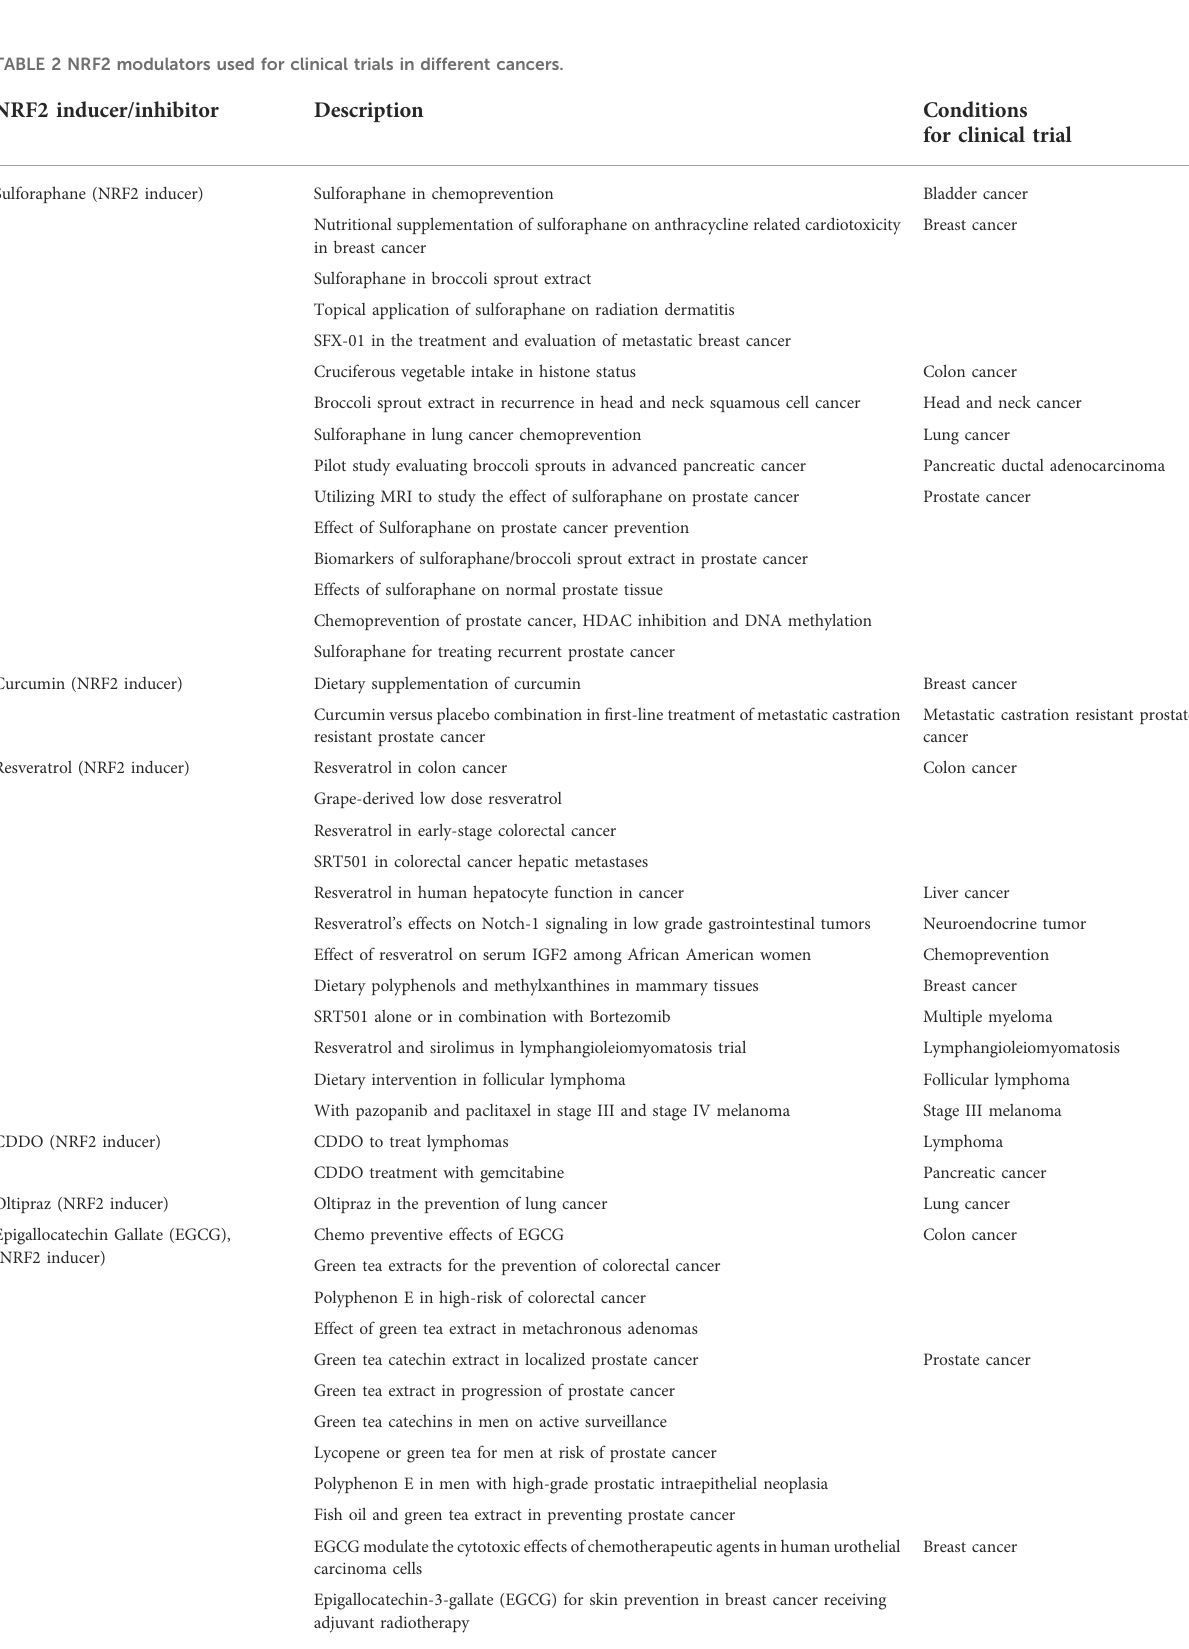
TABLE 2 NRF2 modulators used for clinical trials in different